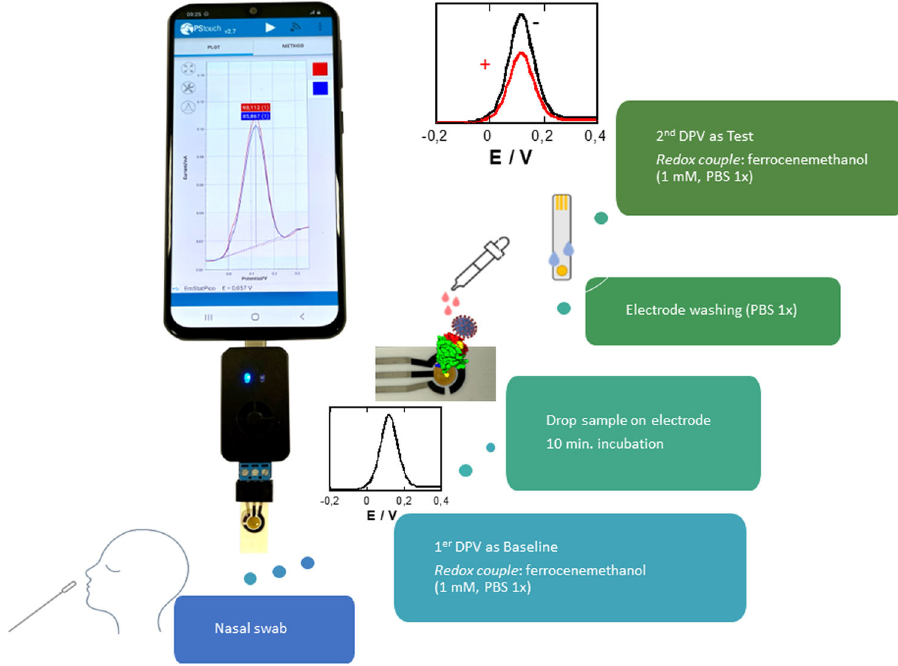
Fig. 3 Nanobody-based COVID-19 voltammetric sensor. Schematic of the sensor concept together with working principle of the sensor and solutions used. Incubation time of sample before test via differential pulse voltammogram using ferrocenemethanol (1 mL, PBS 1×) as a redox probe is 10